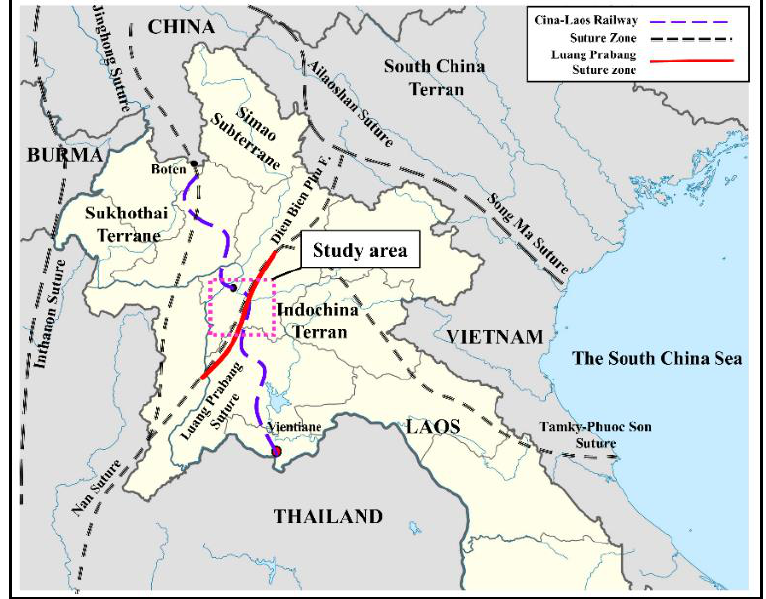
Figure 1. China – Laos Railway location and study area. Figure 1. China–Laos Railway location and study